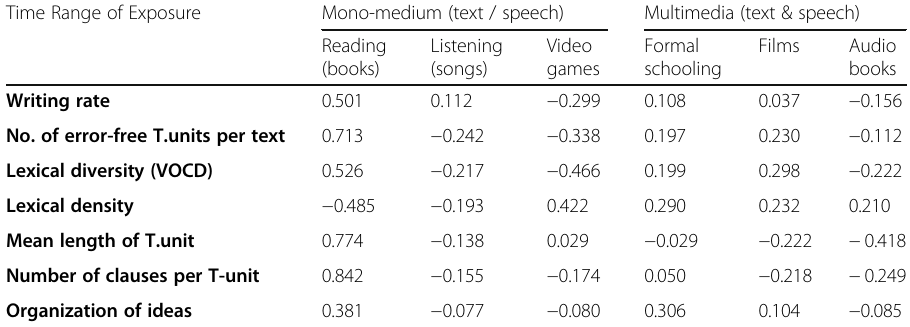
Table 5 Pearson ’ s correlation coefficient: Time Range of Exposure (Offline learning) Time Range of Exposure Mono-medium (text / speech) Multimedia (text & speech) Reading Listening Video Formal Films Audio (books) (songs) games schooling books Writing rate 0.501 0.112 − 0.299 0.108 0.037 − 0.156 No. of error-free T.units per text 0.713 − 0.242 − 0.338 0.197 0.230 − 0.112 Lexical diversity (VOCD) 0.526 − 0.466 0.199 0.298 − 0.222 Lexical density − 0.485 0.422 0.290 0.232 0.210 Mean length of T.unit 0.774 − 0.138 0.029 − 0.029 − 0.222 − 0.418 Number of clauses per T-unit 0.842 − 0.155 − 0.174 0.050 − 0.218 − 0.249 Organization of ideas 0.381 0.306 −